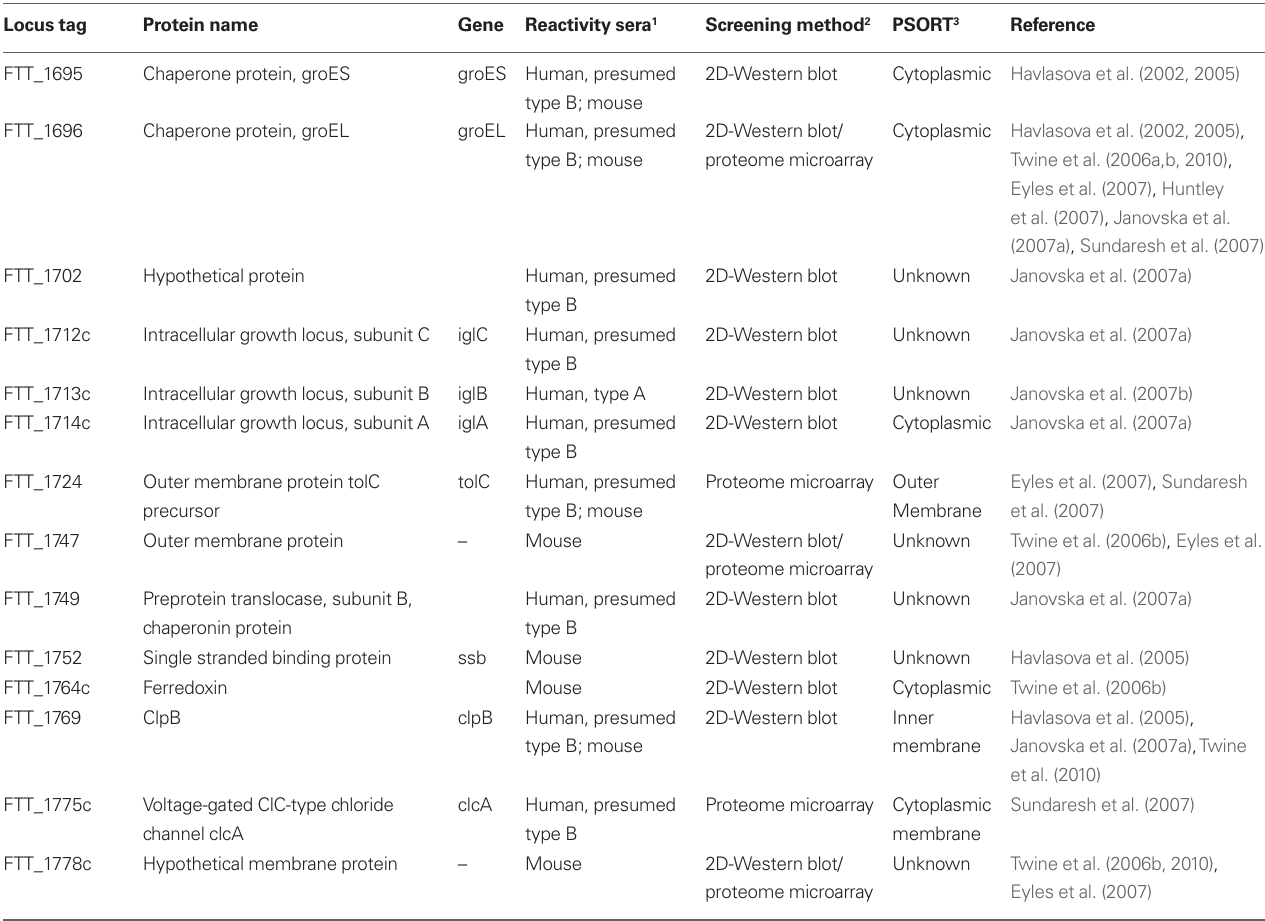
(Twine et al., 2010). Left hand side lists immunoreactive proteins only observed to be reactive with sera from LVS vaccinated BALB/c mice, right hand side shows proteins only reactive with sera from C57/BL6